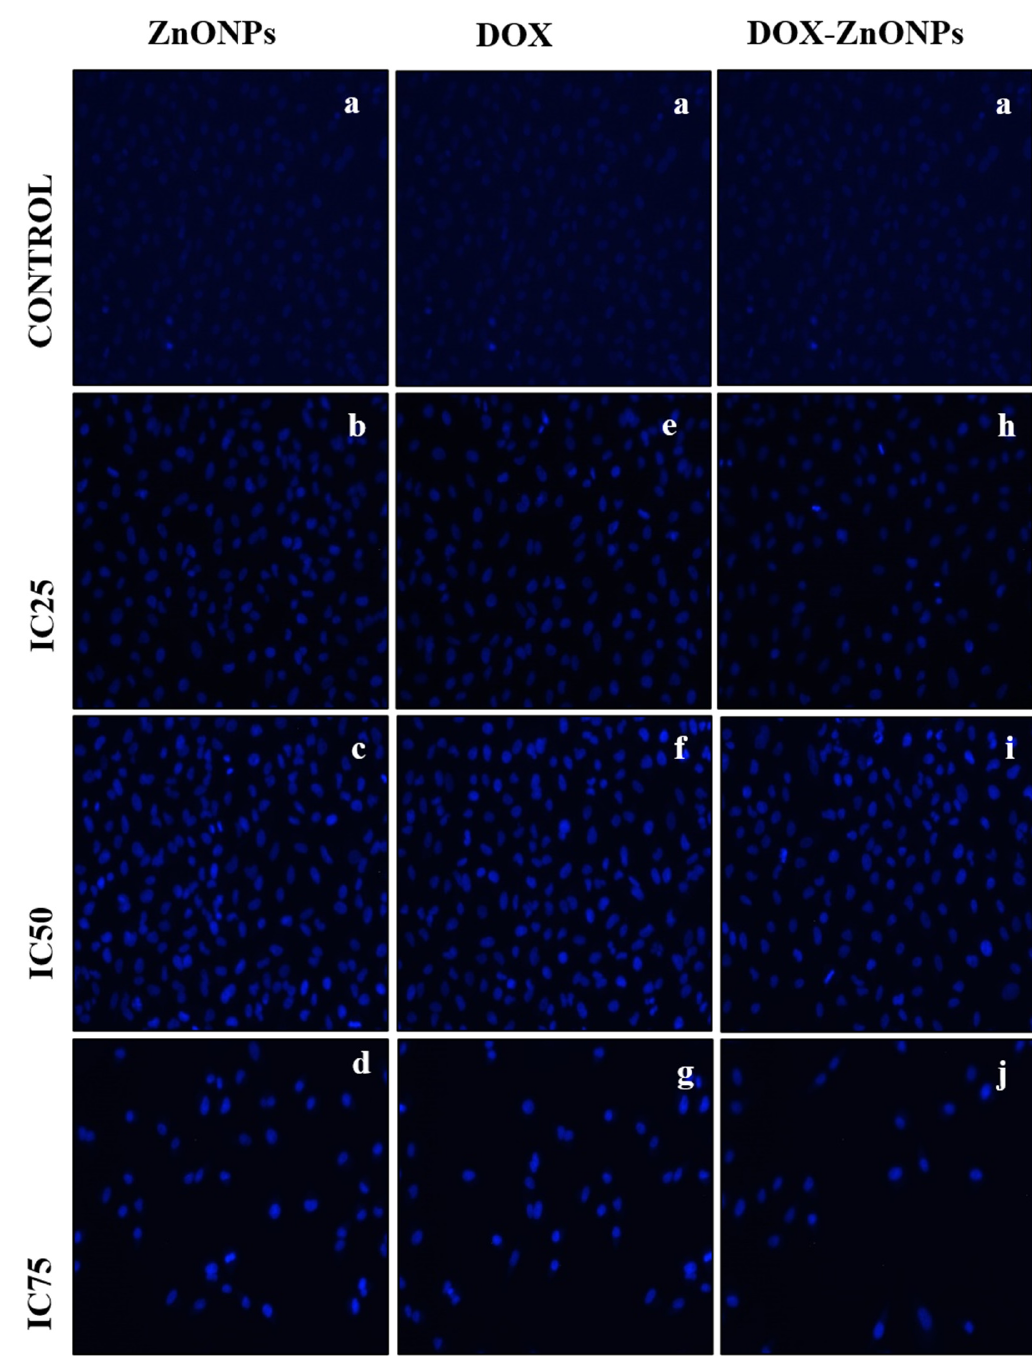
Figure 8. DAPI staining images of A549 cells treated at IC25 [( b ) ZnONPs 27.83 µ g/mL; ( e ) DOX 0.27 µ g/mL; ( h ) DOX-ZnONPs 0.079 µ g/mL], IC50 [( c ) ZnONPs 65.3 µ g/mL; ( f ) DOX 0.56 µ g/mL; ( i ) DOX-ZnONPs 0.34 µ g/mL] and IC75 [( d ) ZnONPs 70.41 µ g/mL; ( g ) DOX 0.72 µ g/mL; ( j ) DOX- ZnONPs 0.69 µ g/mL] concentrations. Vehicle control group image is shown as ( a ). Images shown are representative of three independent